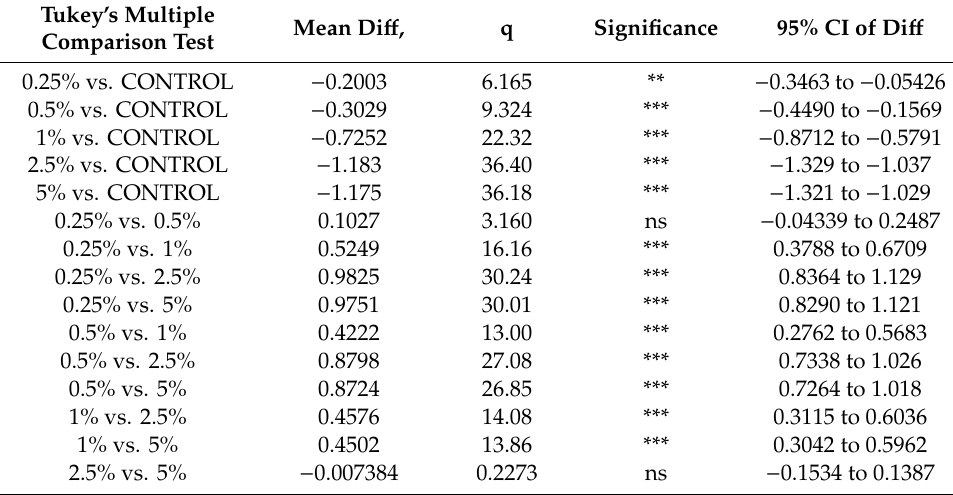
Table 3. Results of Tukey’s test for mouse fibroblasts viability with BioAKT